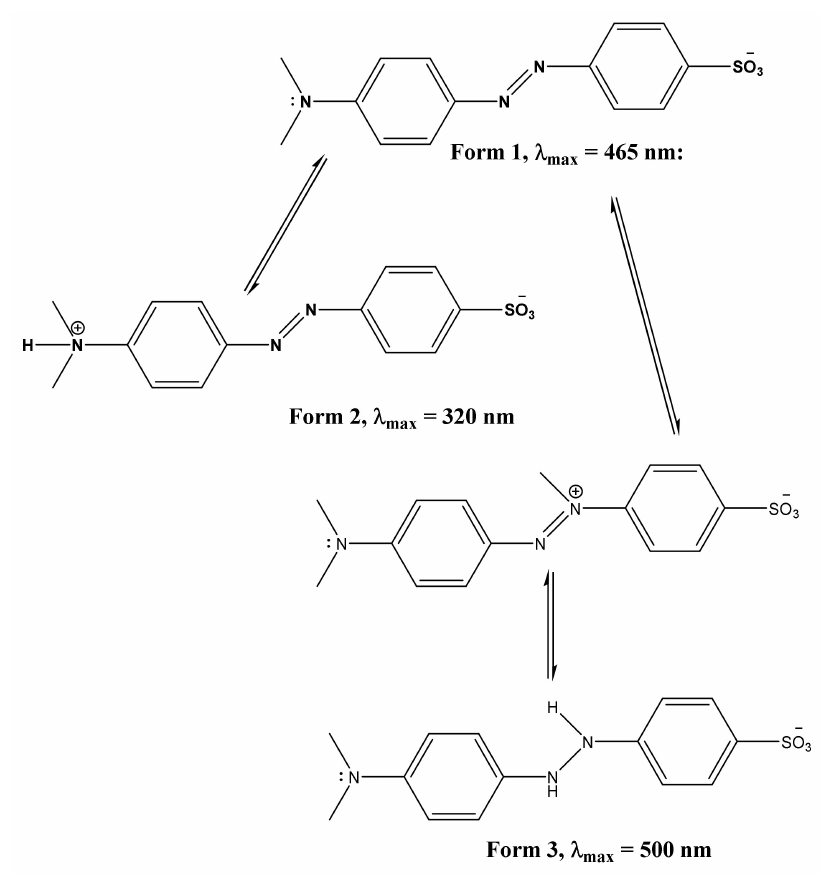
Figure 1. The species formed after protonation of methyl orange.